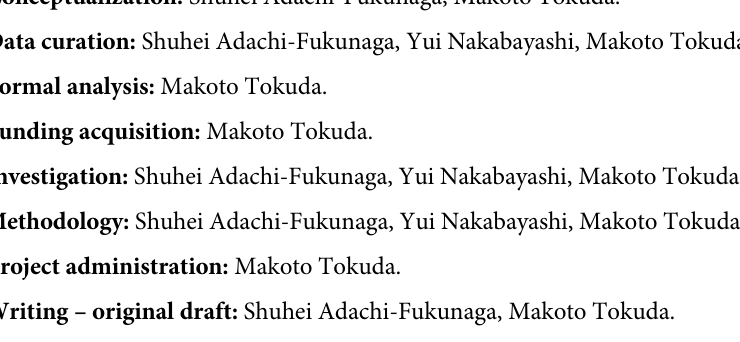
S7 Table. Raw data of seed weight in the progeny of Riptortus pedestris infested (high den- sity) and non-infested (control) Glycine soja